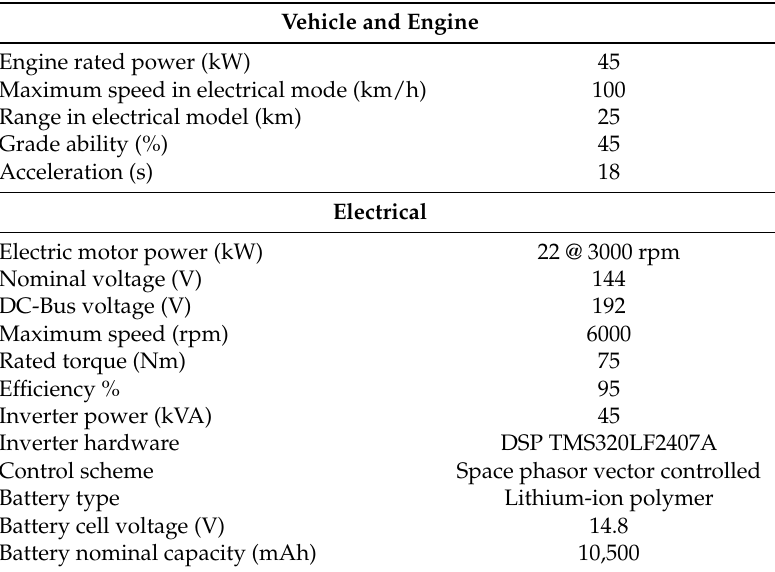
Figure 7. Block diagram of Shaheb 2 architecture [18]. Table 4. Technical data of Shaheb 2